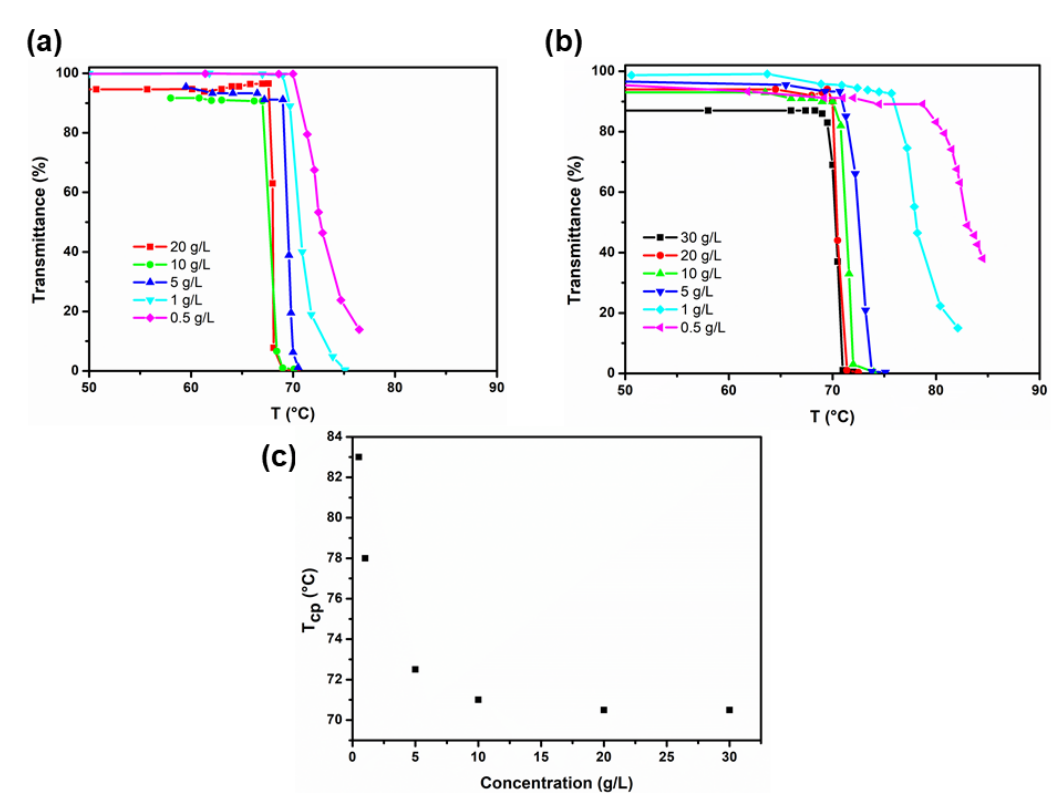
Figure 3. Turbidimetry measurements at different aqueous solution concentrations for ( a ) pEFS8-26 and ( b ) pEFS8-46; ( c ) cloud point temperatures as a function of aqueous solution concentration for pEFS8-26.